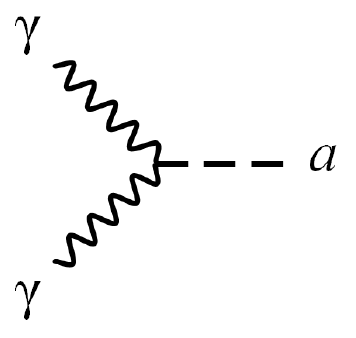
Figure 1. Photon-photon-ALP vertex with coupling constant g a γγ .